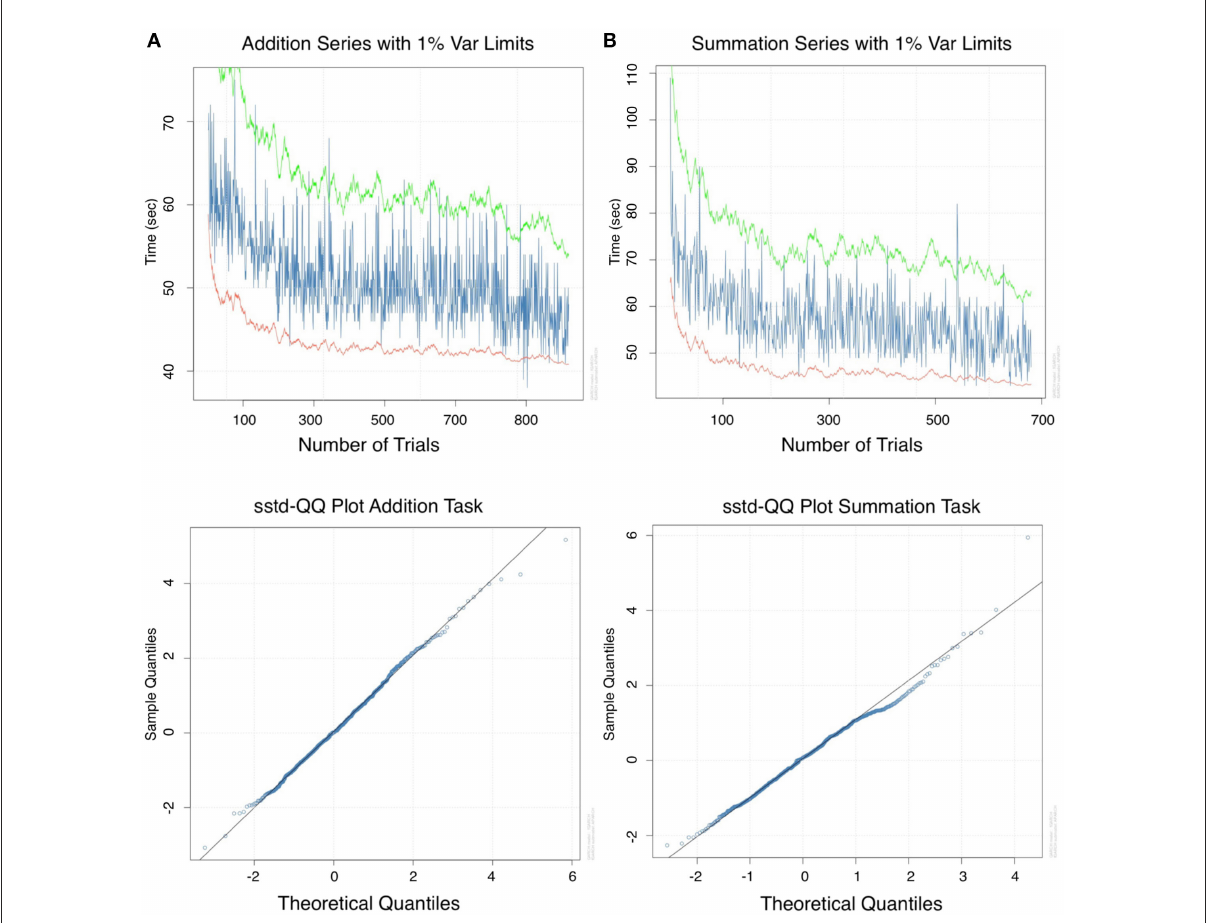
FIGURE4 Analysis in the time domain for return period data: Generalized autoregressive conditional heteroscedasticity (GARCH) model for (A) addition and (B) for summation with 1% variance lines. A GARCH model was required for this period due to volatility in the series, this was likely due to the number of complementary operations in a single calculation, a variable unaccounted for in the model. QQ plots of the standard residuals for both tasks demonstrated a favorable model